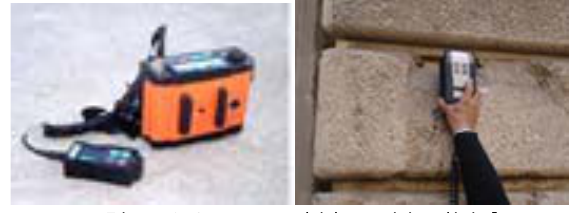
Figure 9. Covermeter high precision digital